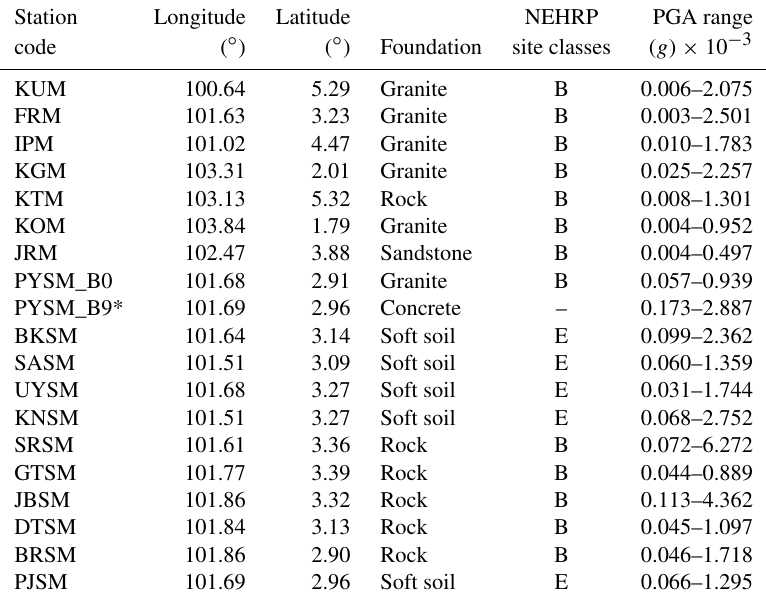
Table 1. Location of MMD seismic stations across Peninsular Malaysia and the ground motion values recorded for the period 2004–2016 by the